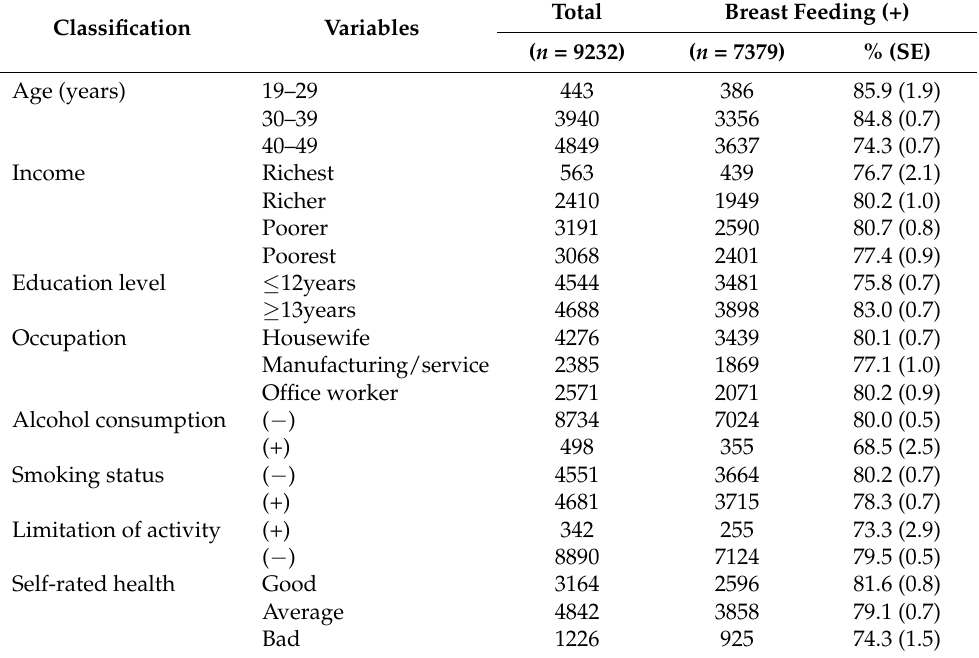
Abbreviations: SE, standard error. Data are presented as percentages